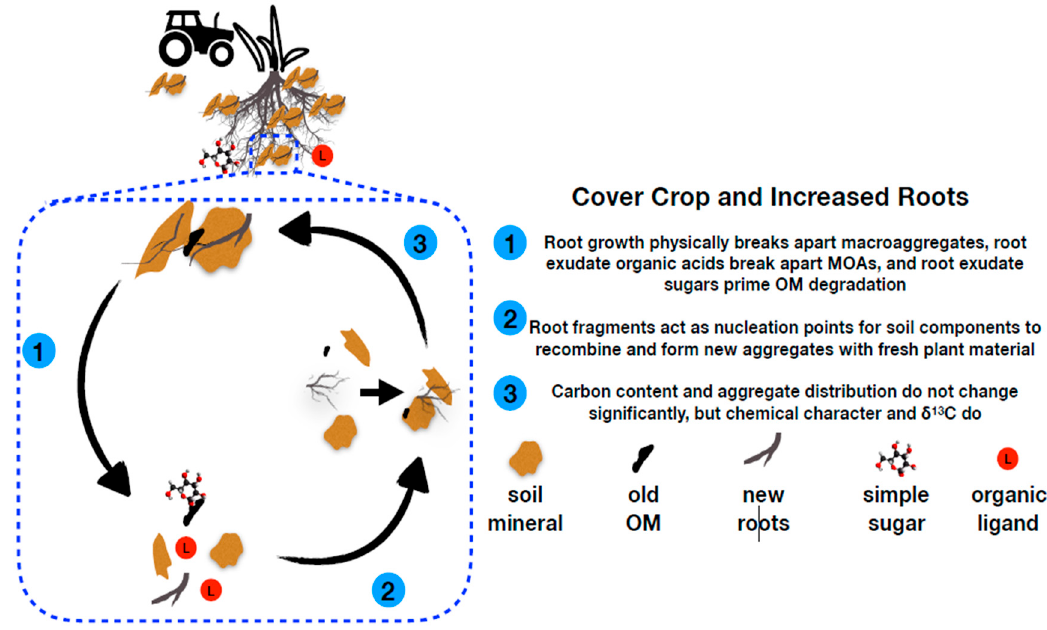
Figure 6. Conceptual model of the influence of cover crop roots on fresh carbon incorporation into macroaggregates. Root growth (and potentially the act of planting cover crop) physically breaks apart macroaggregates while organic acids disrupt mineral-organic associations (MOAs). These processes, combined with organic matter decomposition stimulated by root sugars, lead to enhanced carbon turnover in cover crop soil. However, carbon loss due to root exudates is balanced and slightly exceeded by input of additional root biomass. Although bulk carbon contents do not significantly change, cover crop accelerates carbon turnover in soil macroaggregates.